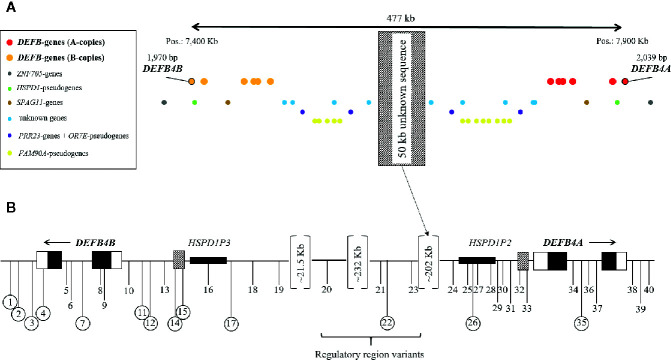

DEFB4 locus on chromosome 8p23.1 with surrounding genes and pseudogenes (A) and location of the 40 selected SNPs for genotyping in GABRIELA Ulm (B). (A) Red dots: A-copies of the β-defensin genes; orange dots: B-copies of the β-defensin genes; red and orange dots with black circle: DEFB4 genes. Blue dots: unknown genes; yellow dots: FAM90A-pseudogenes; purple dots: PRR23-genes and OR7E-pseudogenes; brown dots: SPAG11-genes; green dots: HSPD1-pseudogenes; grey dots: ZNF705-genes. The hatched rectangle in the middle represents a not yet sequenced 50 Kb area, which presents like a mirror in this cluster. (B) positions of the selected SNPs for genotyping are shown as black vertical lines with numbers in relation to the position of DEFB4A and DEFB4B. Circled numbers represent SNPs that were successfully genotyped. Black boxes refer to exonic regions, white boxes to UTRs, hatched boxes to putative promoter regions.